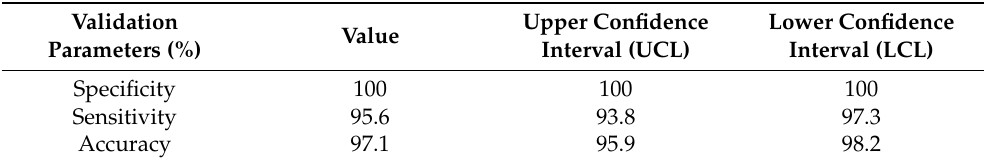
Table 9. Basic parameters describing the MSD for horse meat as a